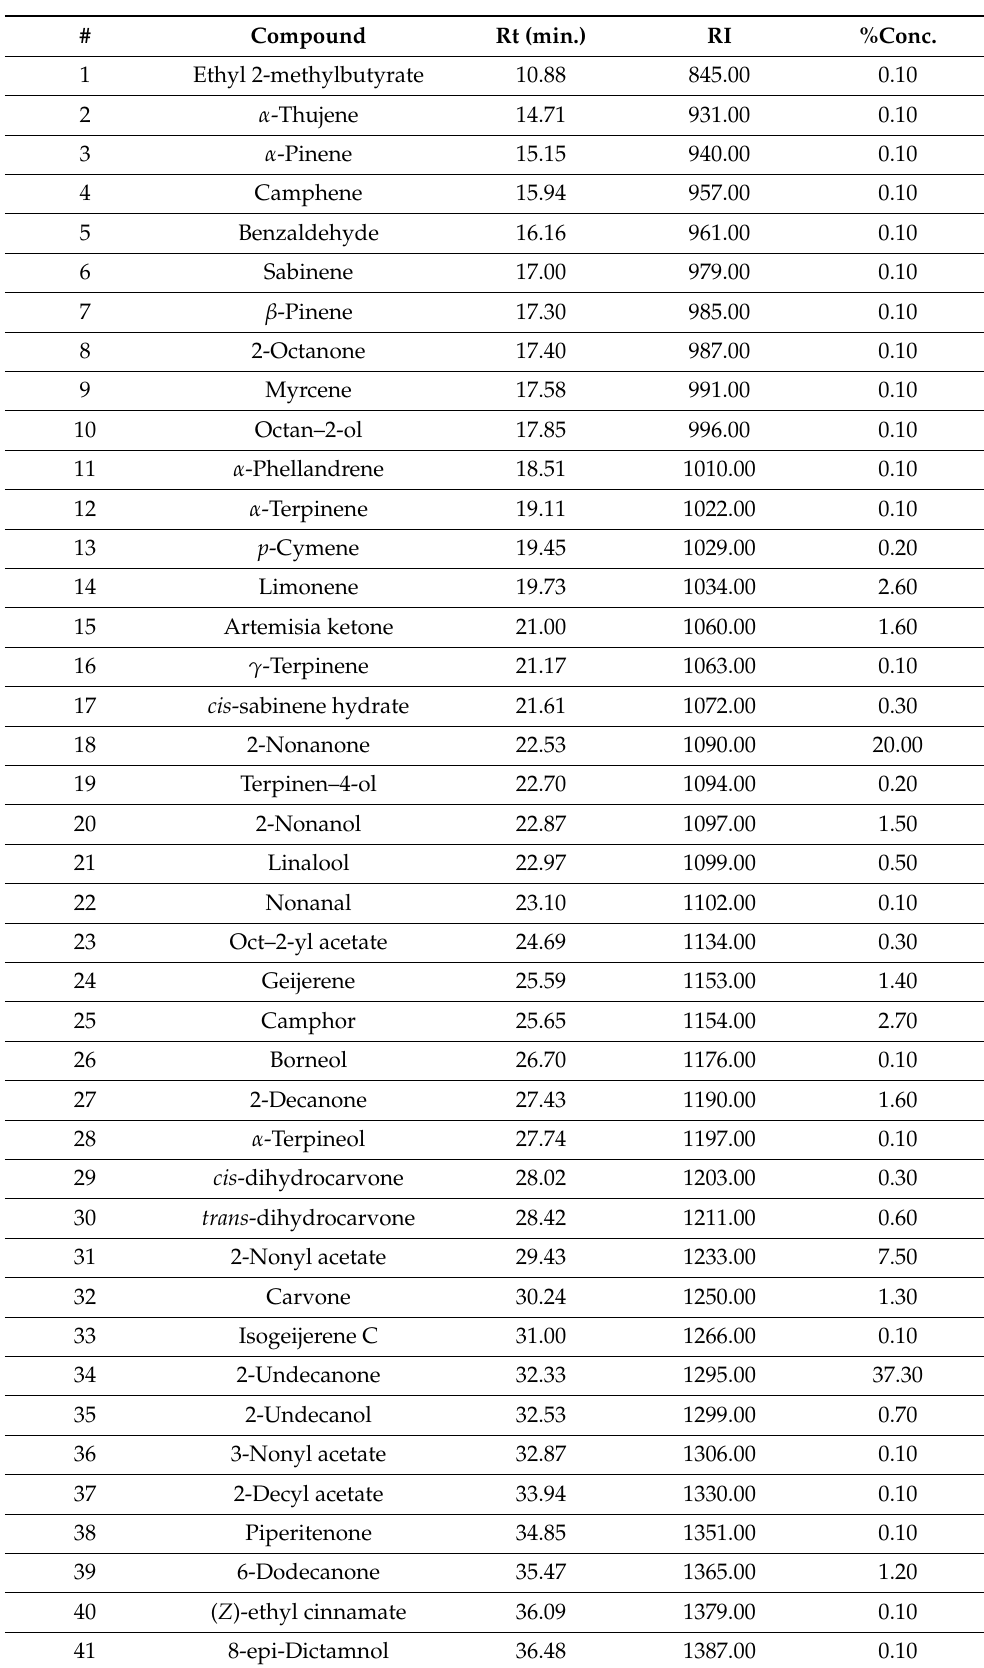
Table 1. Composition of the Ruta chalepensis aerial part essential oil extracted using